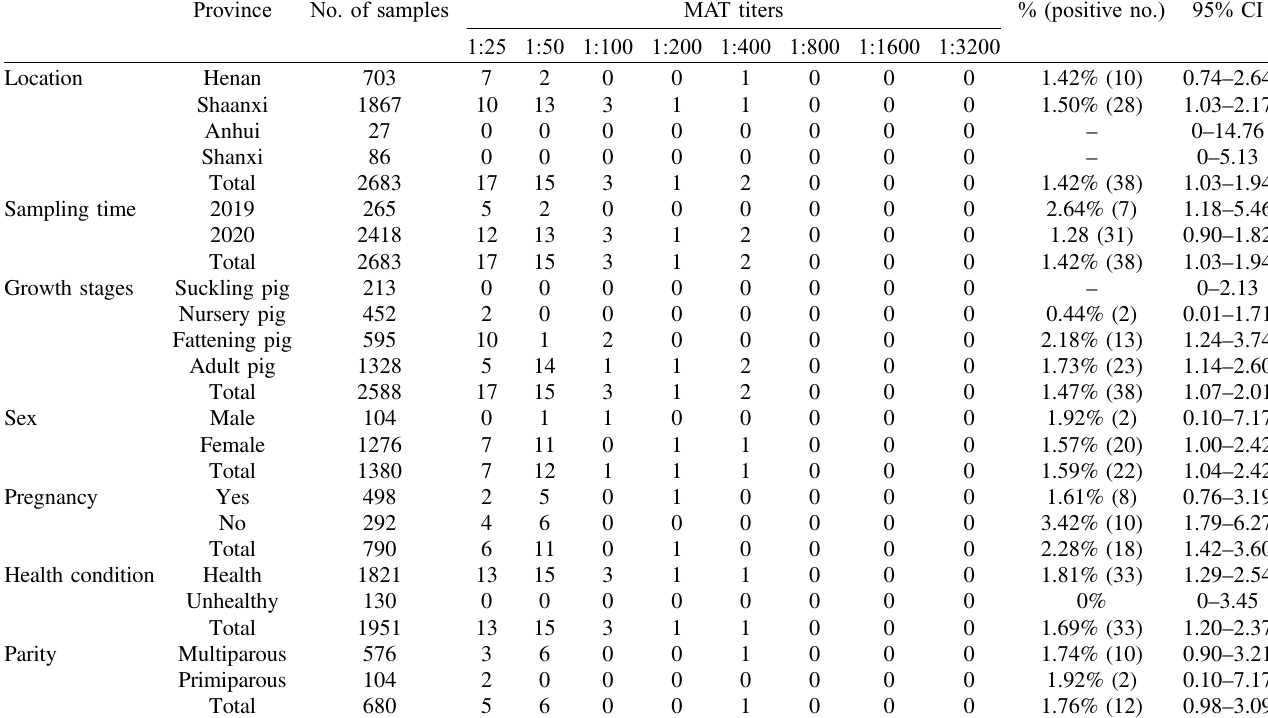
Table 1. Seroepidemiology and background information on Toxoplasma gondii in 2683 swine.